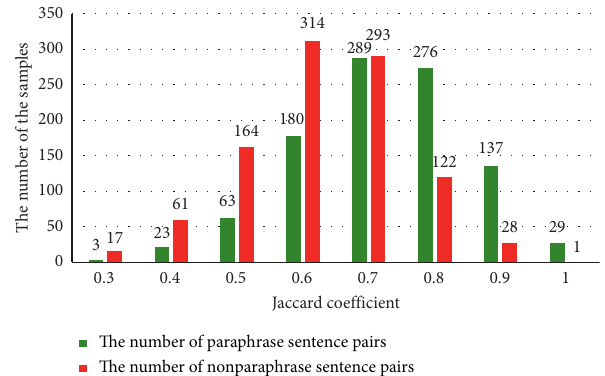
Figure 3: Comparison of syntactic similarity between paraphrase pairs and nonparaphrase pairs using Jaccard coefficient.